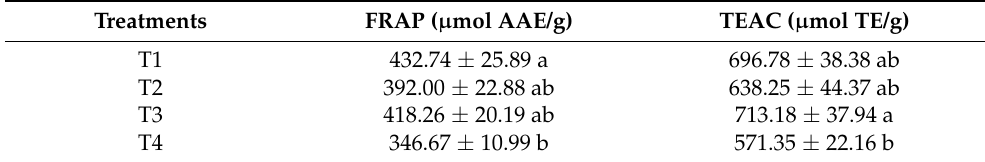
Table 3. Effect of fungal inoculation on antioxidants capacity. Treatments